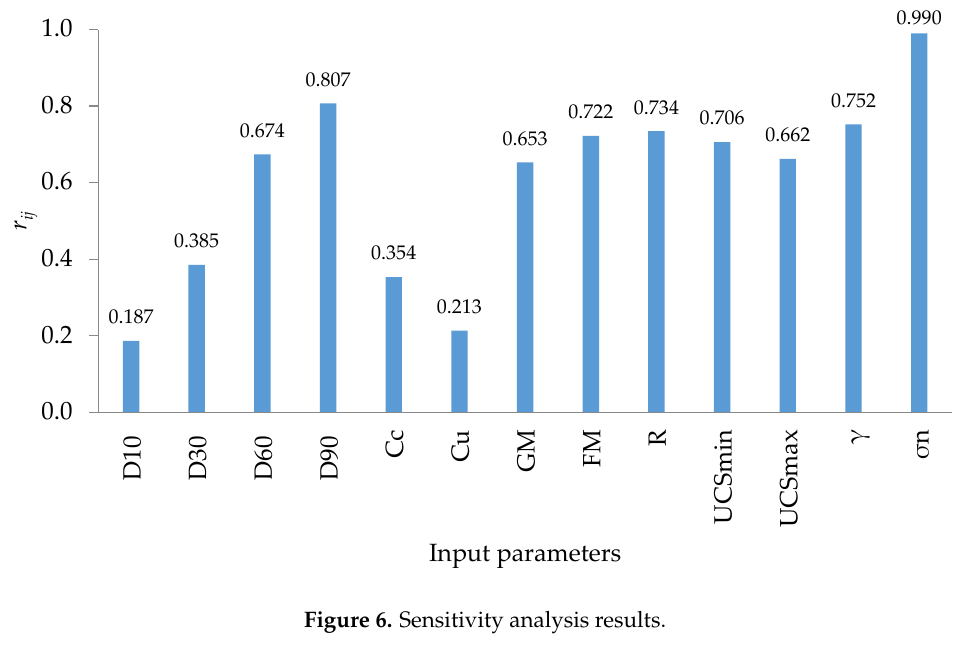
Figure 6. Sensitivity analysis results.